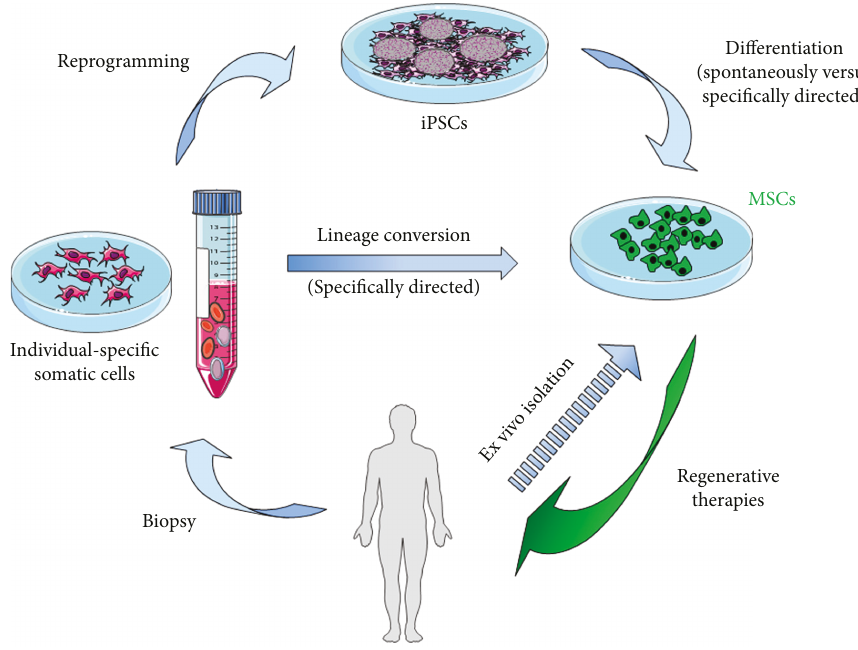
Figure 1: Patient-speci fi c adult MSCs. Somatic cells (e.g., fi broblasts and peripheral blood cells) can be isolated from individual healthy or diseased donors (biopsy) and (i) directly converted into MSCs or (ii) reprogrammed into iPSCs by the introduction of the common transcription (Yamanaka) factors OCT4 , SOX2 , KLF4 , and c-MYC . iPSCs were characterized by inde fi nite self-renewal and